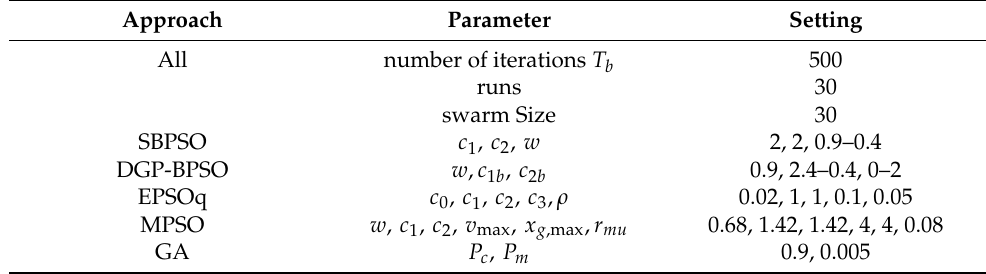
Table 4. Parameter setting for the BPSO variants.